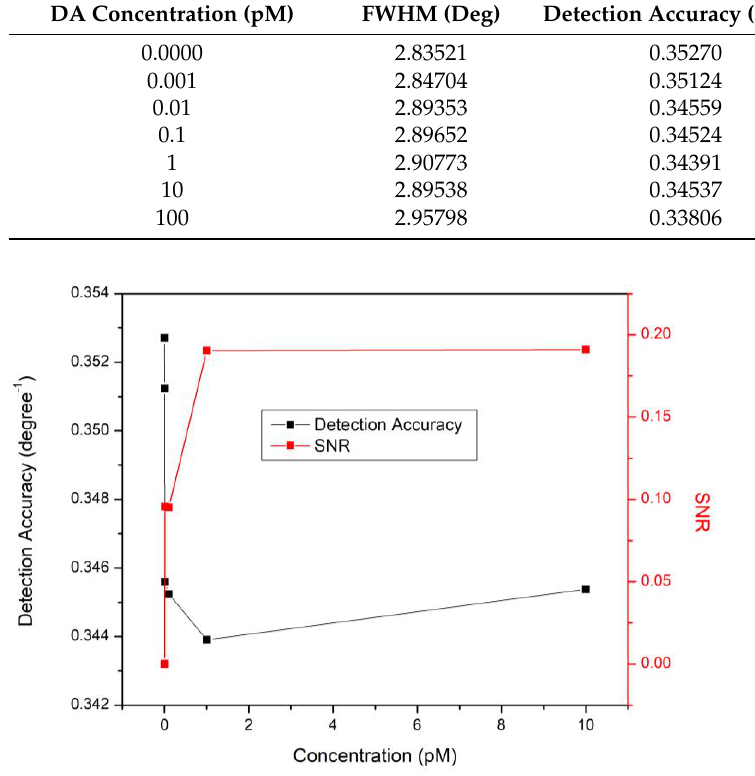
Figure 9. Detection accuracy and SNR of the DA SPR sensor based on CQD thin film .